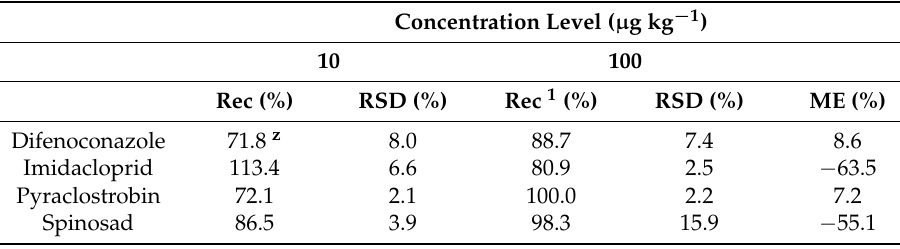
Table 3. Percentage of recovery (Rec %), relative standard deviation (RSD %) at 10 and 100 µ g kg − 1 concentration levels in mandarin and matrix effects percentage (ME